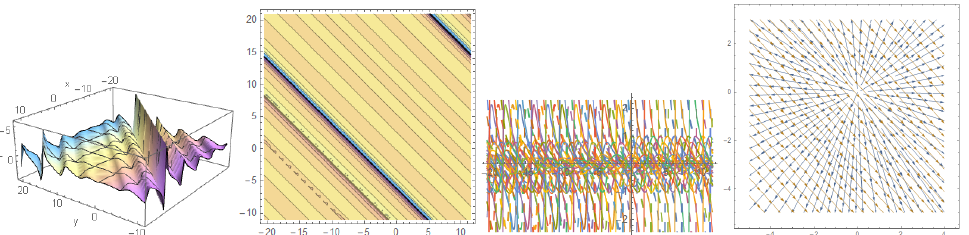
Figure 4. The dynamical behavior of MSR with one exponential function solution via g 6 = 8,